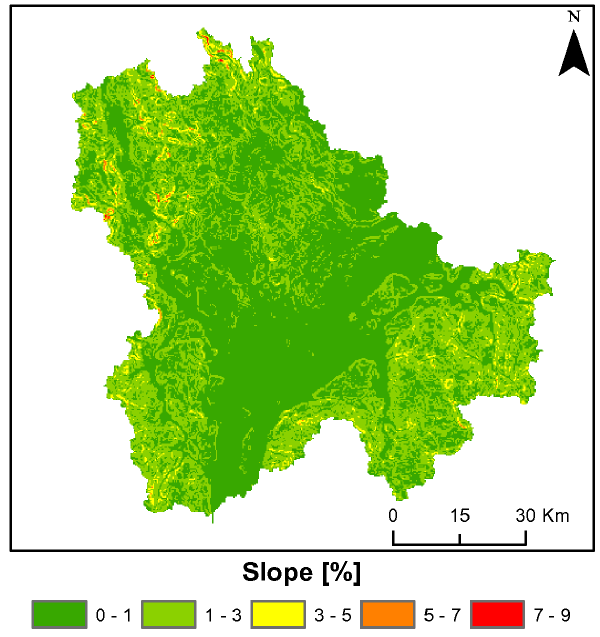
Figure 2. Slope map of the study